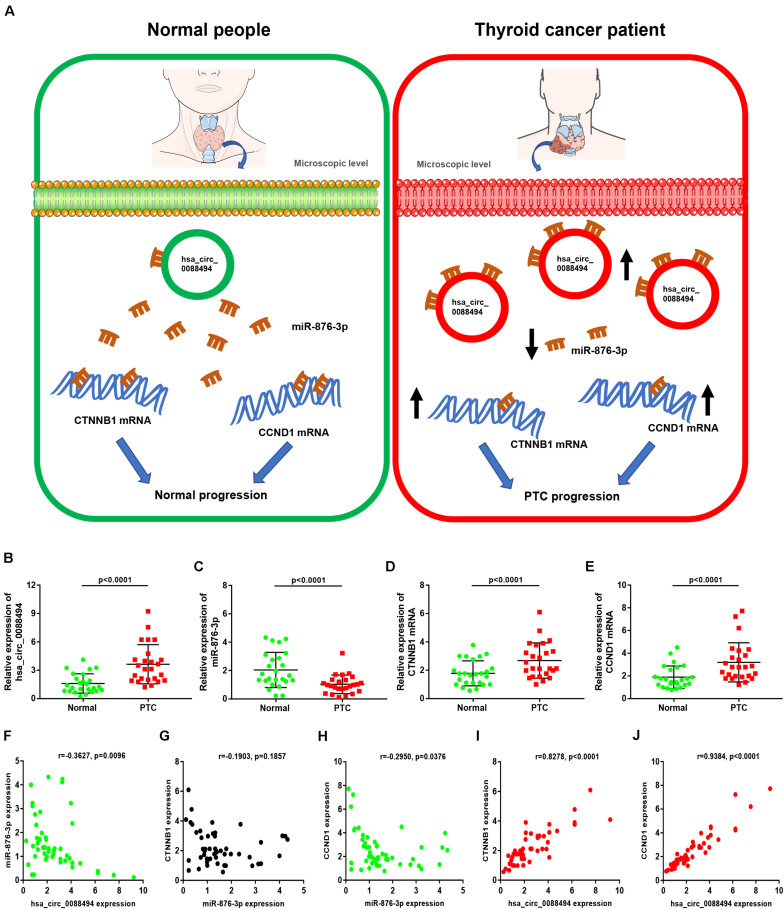
Construction and validation of a potential axis (hsa_circ_0088494-miR-876-3p-CTNNB1/CCND1) involved in progression of thyroid carcinoma. (A) The model of hsa_circ_0088494-miR-876-3p-CTNNB1/CCND1 axis in PTC. (B) Hsa_circ_0088494 expression in 25 pairs PTC and adjacent normal tissues. (C) MiR-876-3p expression in 25 pairs PTC and adjacent normal tissues. (D) CTNNB1 mRNA expression in 25 pairs PTC and adjacent normal tissues. (E) CCND1 mRNA expression in 25 pairs PTC and adjacent normal tissues. (F) Expression correlation of hsa_circ_0088494 with miR-876-3p in PTC. (G) Expression correlation of CTNNB1 with miR-876-3p in PTC. (H) Expression correlation of CCND1 with miR-876-3p in PTC. (I) Expression correlation of hsa_circ_0088494 with CTNNB1 in PTC. (J) Expression correlation of hsa_circ_0088494 with CCND1 in PTC. “p < 0.05” was considered as statistically significant.